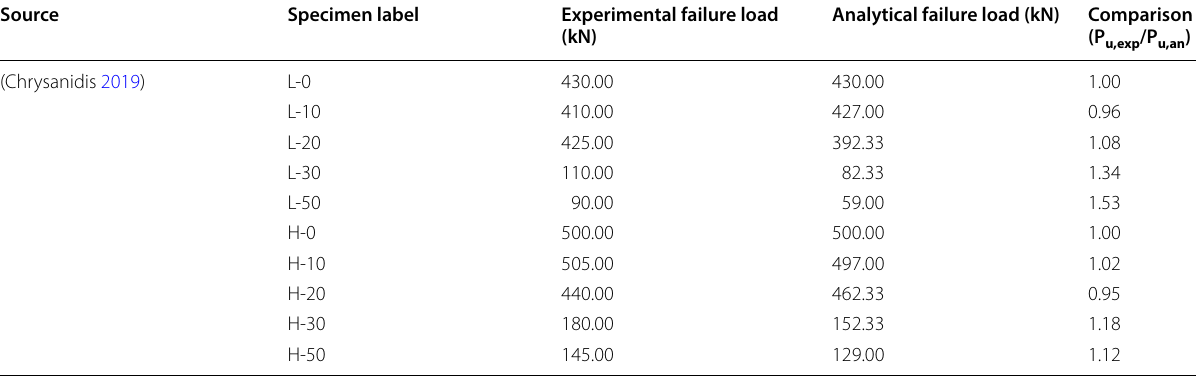
Table 9 Comparison between measured and empirical maximum failure load